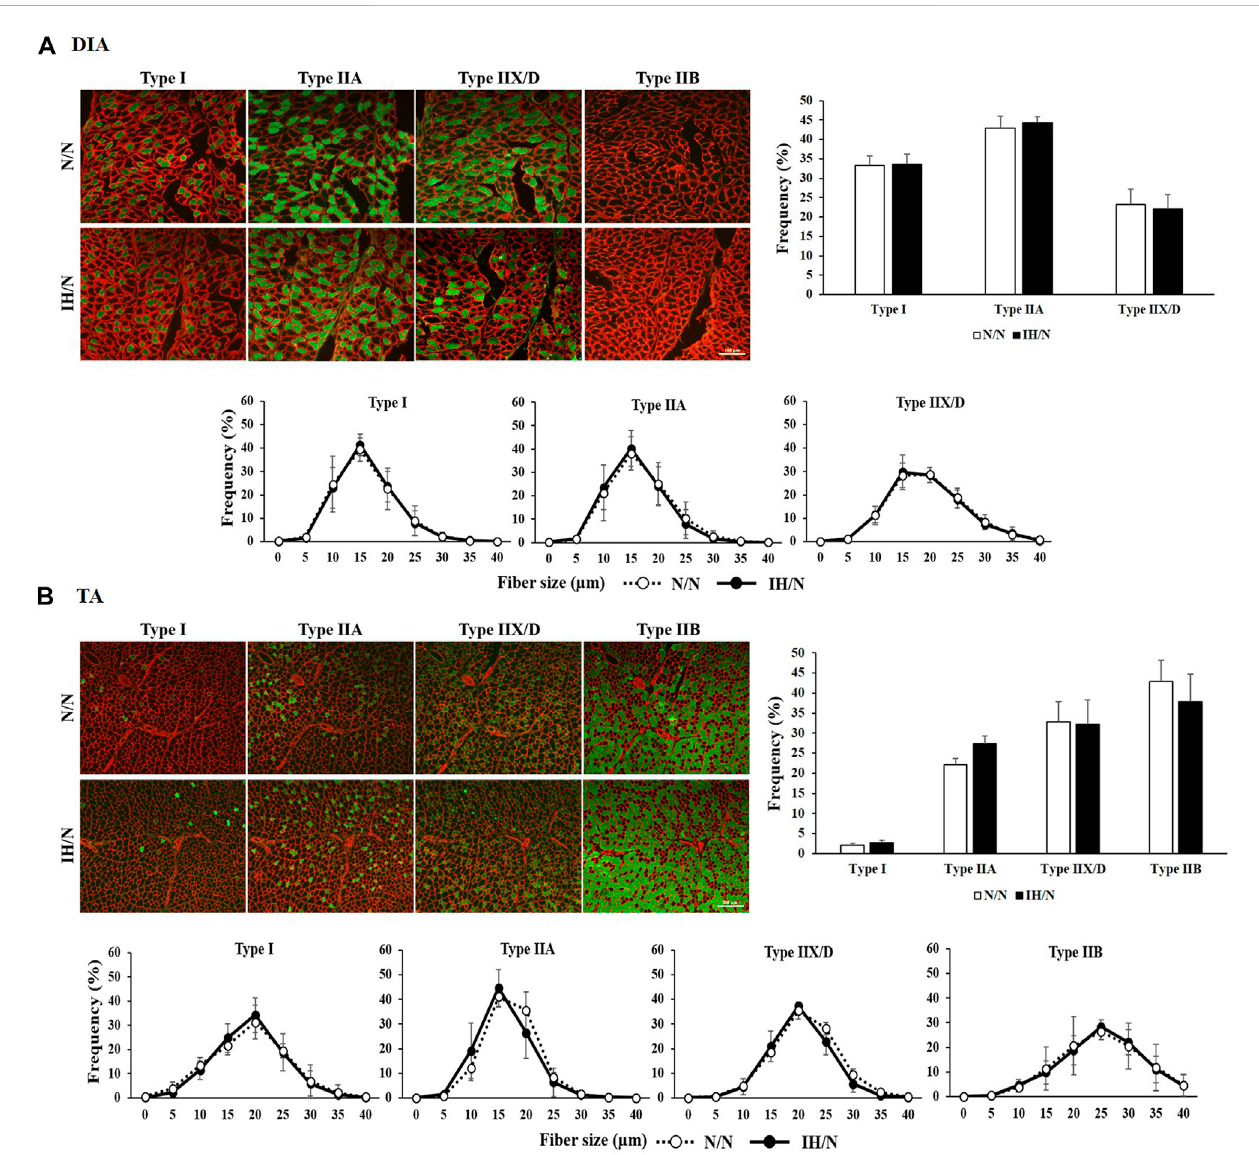
FIGURE 3 Muscle fi bertypedistributionandmuscle fi bersizeintheDIAandTAmusclesofoffspringrats.Fibertype-speci fi cimmunohistochemicalstainingfortype I,typeIIA, type IIX/D, and type IIB fi bers with skeletal muscle membrane protein, laminin(red). Each panel shows thecross-sectional image of the (A) DIA, and (B) TAmuscles.Greenareasindicateimmuno-positivemuscle fi bers.Muscle fi bertypedistributionandsizefrequencyintheDIAandTAshowednosigni fi cant difference between N/N and IH/N rats. Bars represent (A) 100 µm for DIA sections, and (B) 200 µm for TA